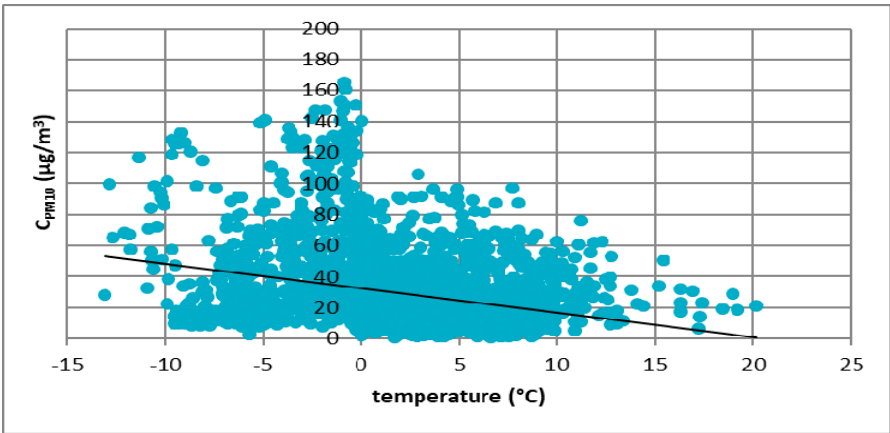
Figure 6. The effect of temperature on PM10 concentration in Gda ń sk in 2017.